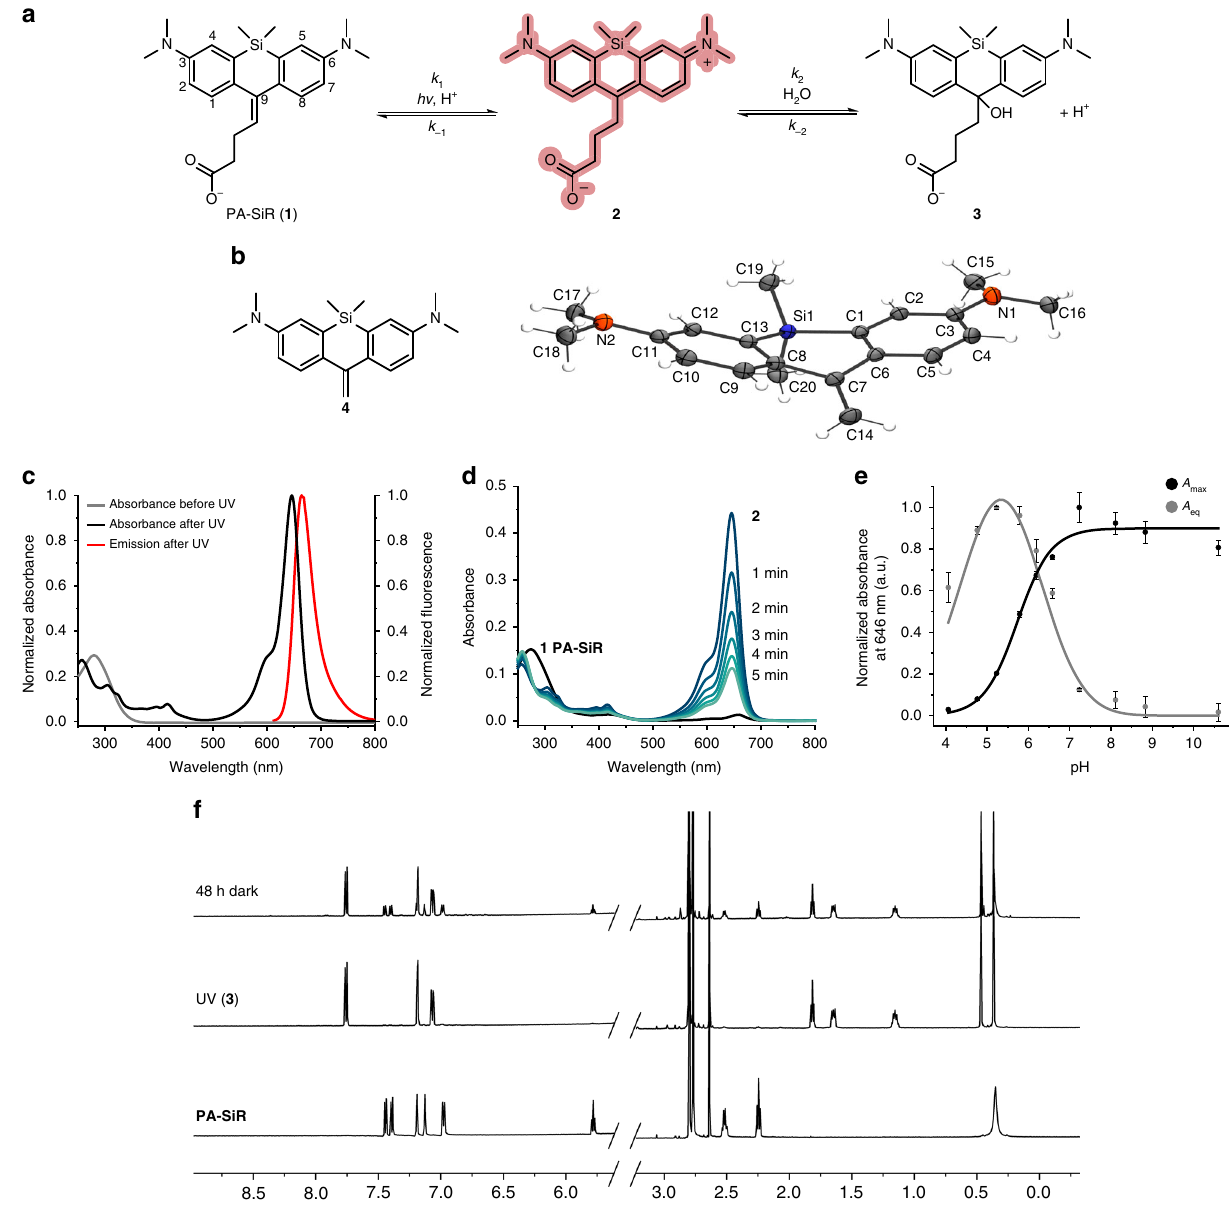
Fig. 1 Structure and properties of PA-SiR. a Reaction scheme for photoactivation of PA-SiR ( 1 ), and equilibrium between 2 and 3 . b Chemical structure of compound 4 together with its Oak Ridge Thermal Ellipsoid Plot (ORTEP), arbitrary numbering. Atomic displacement parameters are drawn at 50% probability level. Selected bond lengths (Å) and torsion angles (°): C4 – C5 1.380(2), C5 – C6 1.3999(19), C6 – C7 1.4896(19), C7 – C8 1.4929(19), C7 – C14